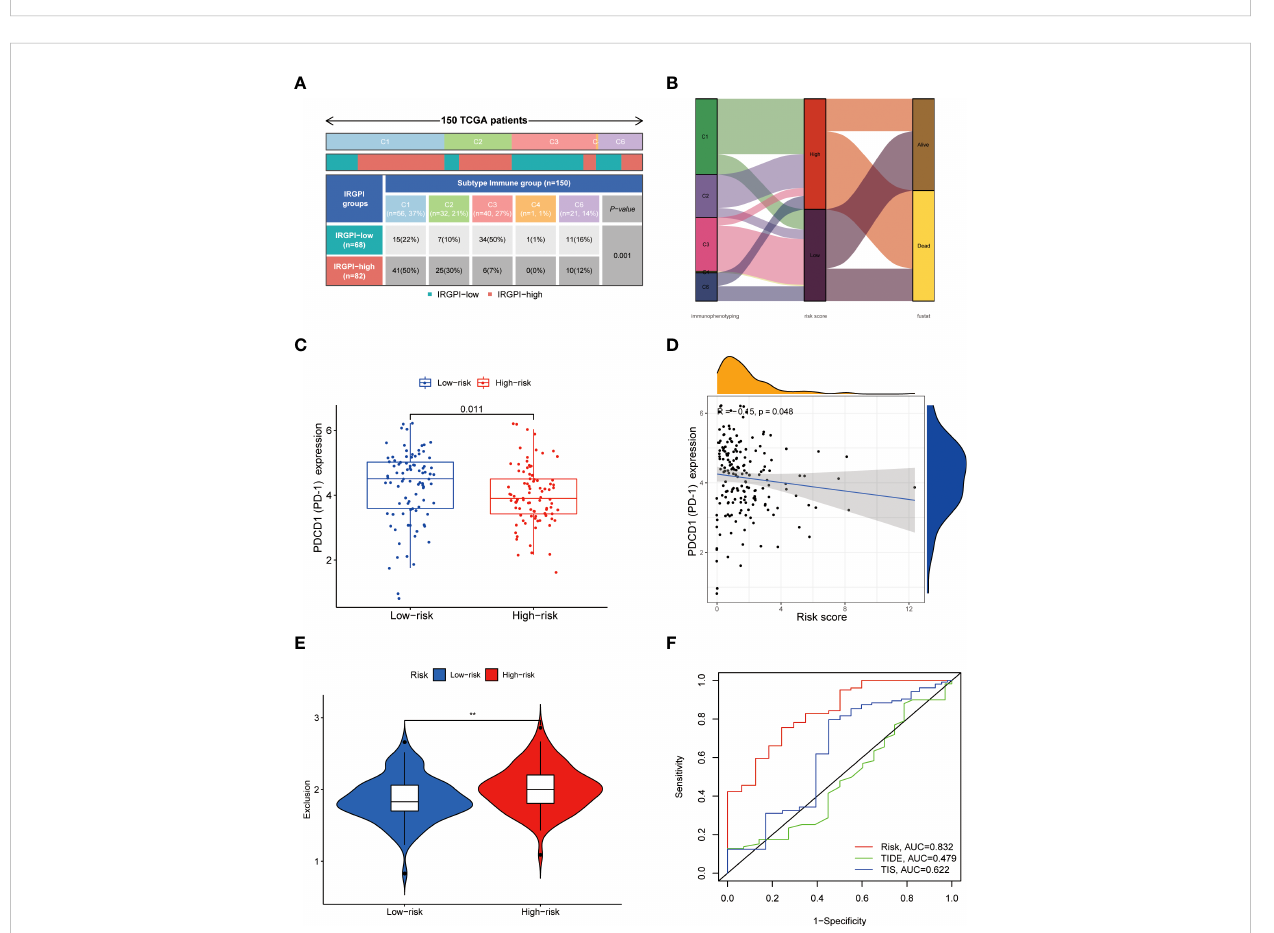
FIGURE 9 Relationship between HAPM and immunotherapy. (A, B) Distribution of immunophenotyping between different subgroups. (C) Differences in PD-1 expression between different subgroups (TCGA-PAAD). (D) Correlation between HAPM and PD-1 (TCGA-PAAD). (E) Differences in T-cell exclusion scores between different subgroups. (F) ROC analysis of HAPM, TIS and TIDE on 3-year OS of TCGA-PAAD